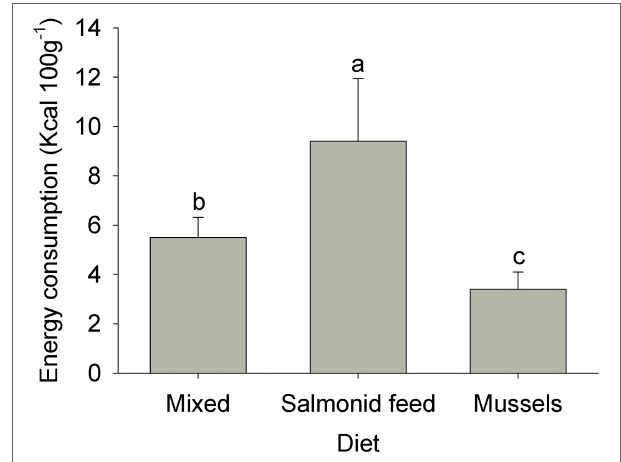
FIGURE 1 | Estimated energy consumption for rock crabs Cancer irroratus fed the different experimental diets. Replicates are the mean values for each experimental tank. Log-transformed data was analyzed, but raw data is presented. Bars show mean +SE and columns not sharing a common letter are significantly different (Tukey HSD post-hoc tests, n =